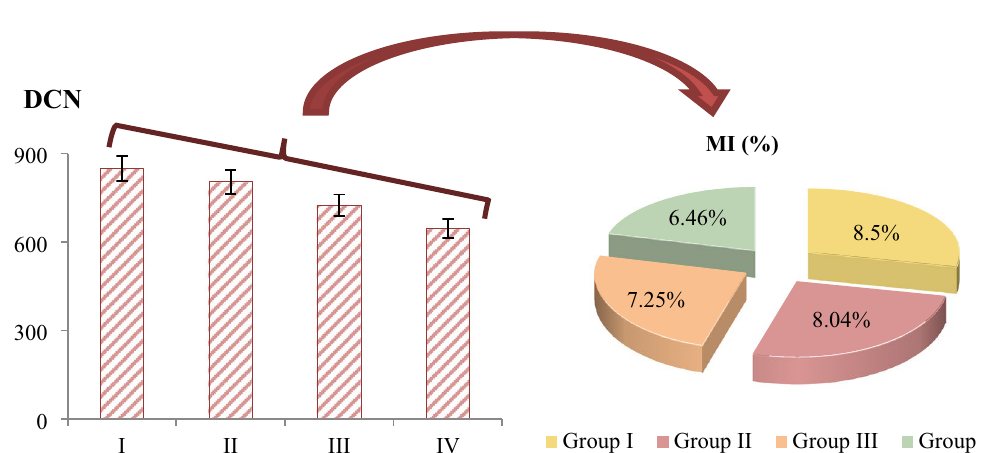
Figure 2. The effects of MnCl 2 on dividing cell number (DCN) and MI (%).Group I: Control, Group II: 250 µM MnCl 2 , Group III: 500 µM MnCl 2 , Group IV: 1000 µM MnCl 2